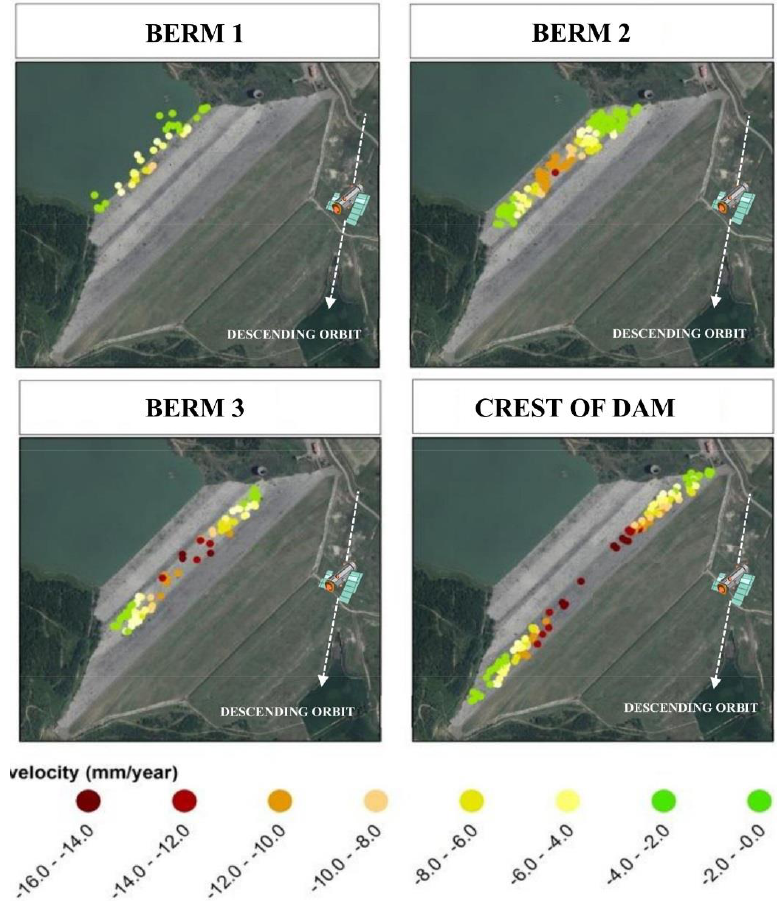
Figure 13. Results from the DInSAR surveying: location of the observed points classified by their average vertical displacement velocity, the white dashed line indicates the satellite descending orbit (Nord-South).